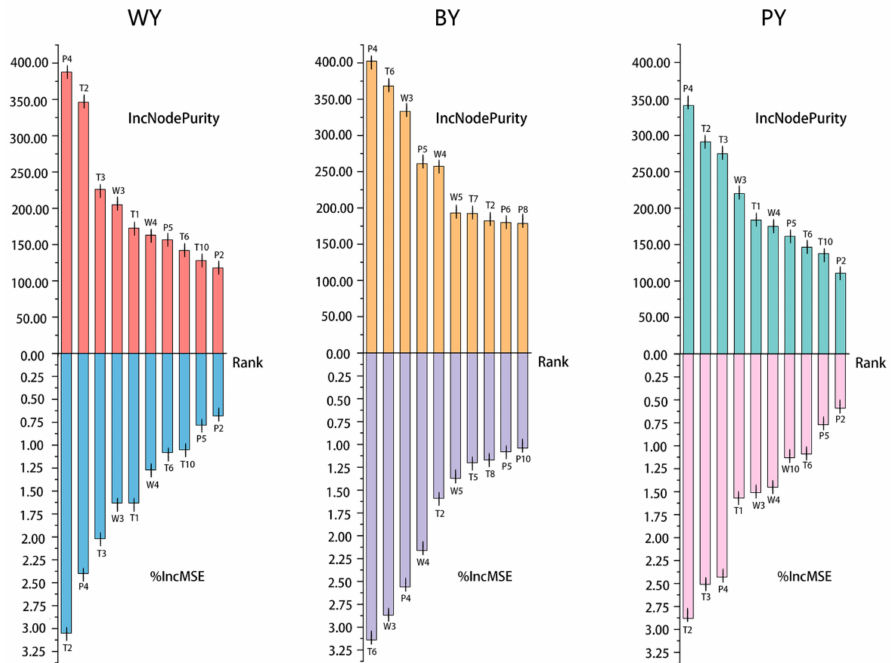
Figure 4. Ranking by importance of climate to yield of staple crops.